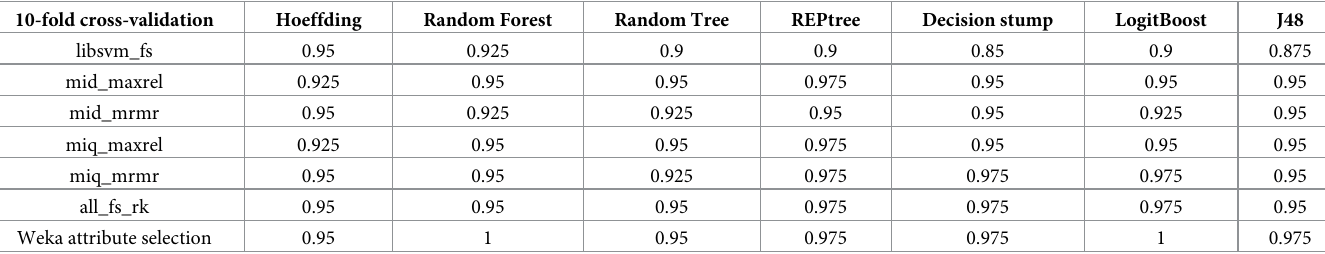
Table 7. The cross-validation results of each stage 2 classifier with different feature selection methods. 10-fold cross-validation